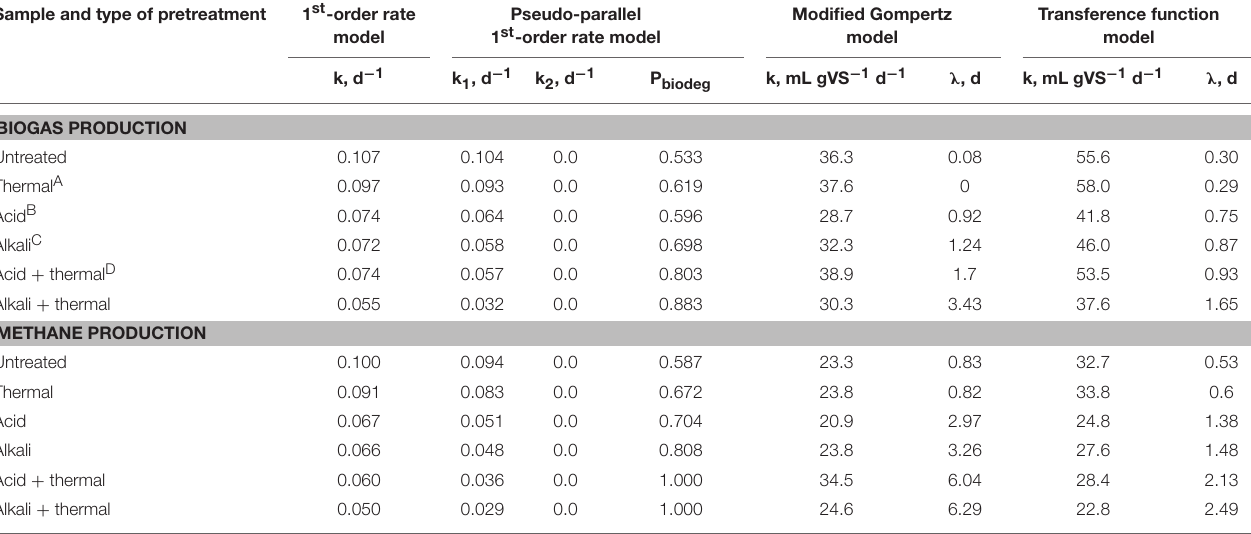
TABLE 2 | Effect of algae pretreatment on biogas and methane production kinetic parameters. Sample and type of pretreatment